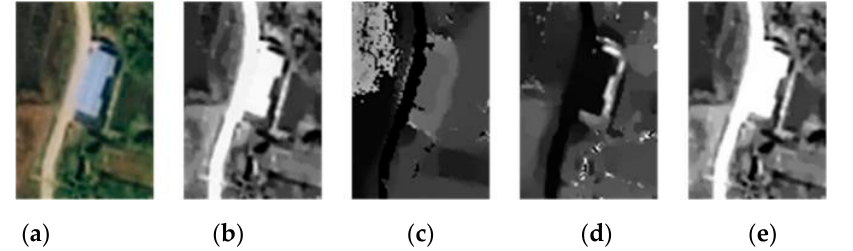
Figure 4. Image. ( a ) Original RGB image; ( b ) gray image; ( c ) hue image; ( d ) saturation image; ( e ) value image.